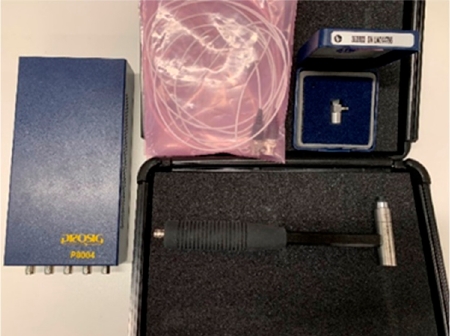
Figure 5. Impact hammer, accelerometer, and the acquisition device with DATs software.